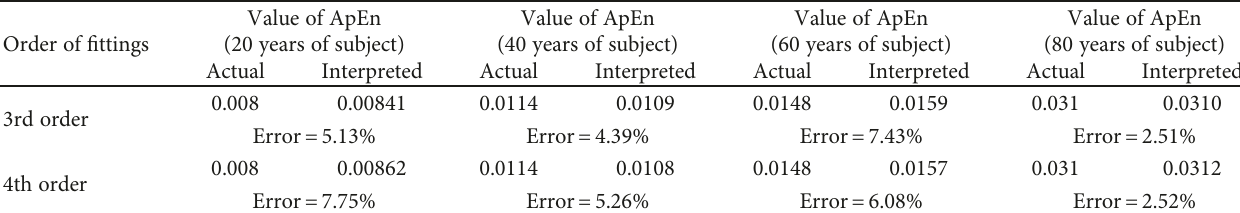
Table 4: Error (% deviation) calculation for di ff erent orders of fi tting and for di ff erent test values (age) of subjects. Order of fi